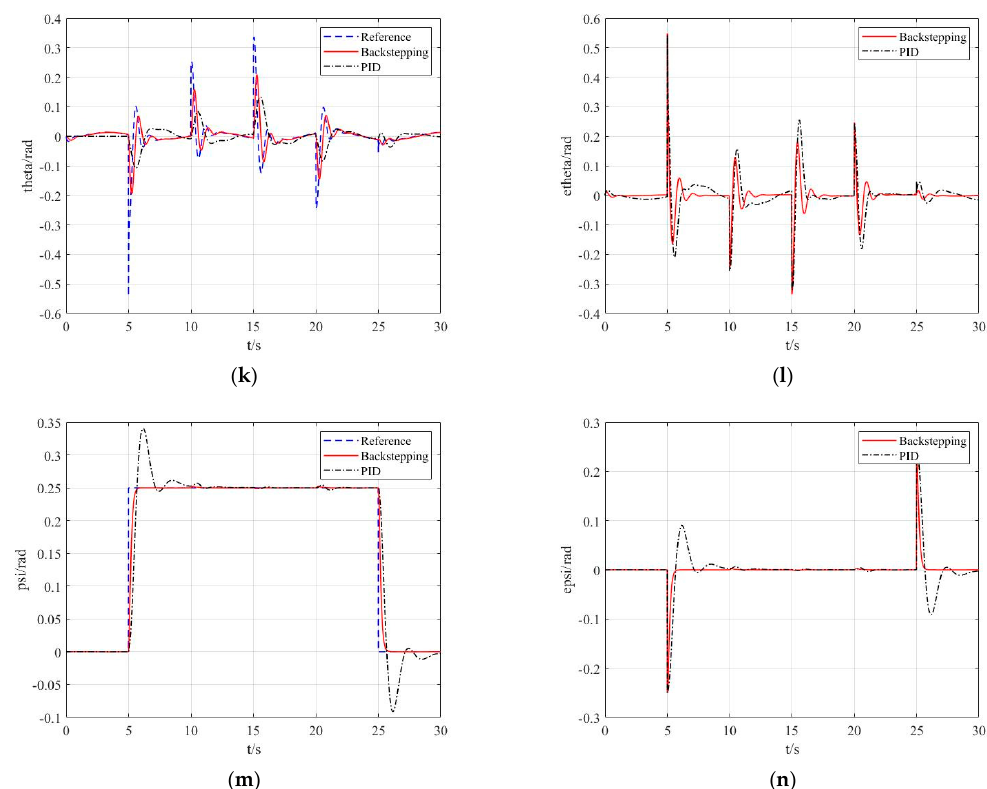
Figure 22. Curve of quadcopter trajectory tracking responses. ( a ) 3D curve of trajectory tracking. ( b ) Curve of trajectory tracking errors. ( c ) Curve of trajectory tracking along the x -axis. ( d ) Curve of trajectory tracking errors along the x -axis. ( e ) Curve of trajectory tracking along the y -axis. ( f ) Curve of trajectory tracking errors along the y -axis. ( g ) Curve of trajectory tracking along the z -axis. ( h ) Curve of trajectory tracking errors along the z -axis. ( i ) Curve of roll angle responses. ( j ) Curve of roll angle tracking errors. ( k ) Curve of pitch angle responses. ( l ) Curve of pitch angle tracking errors. ( m ) Curve of yaw angle responses. ( n ) Curve of yaw angle tracking errors.